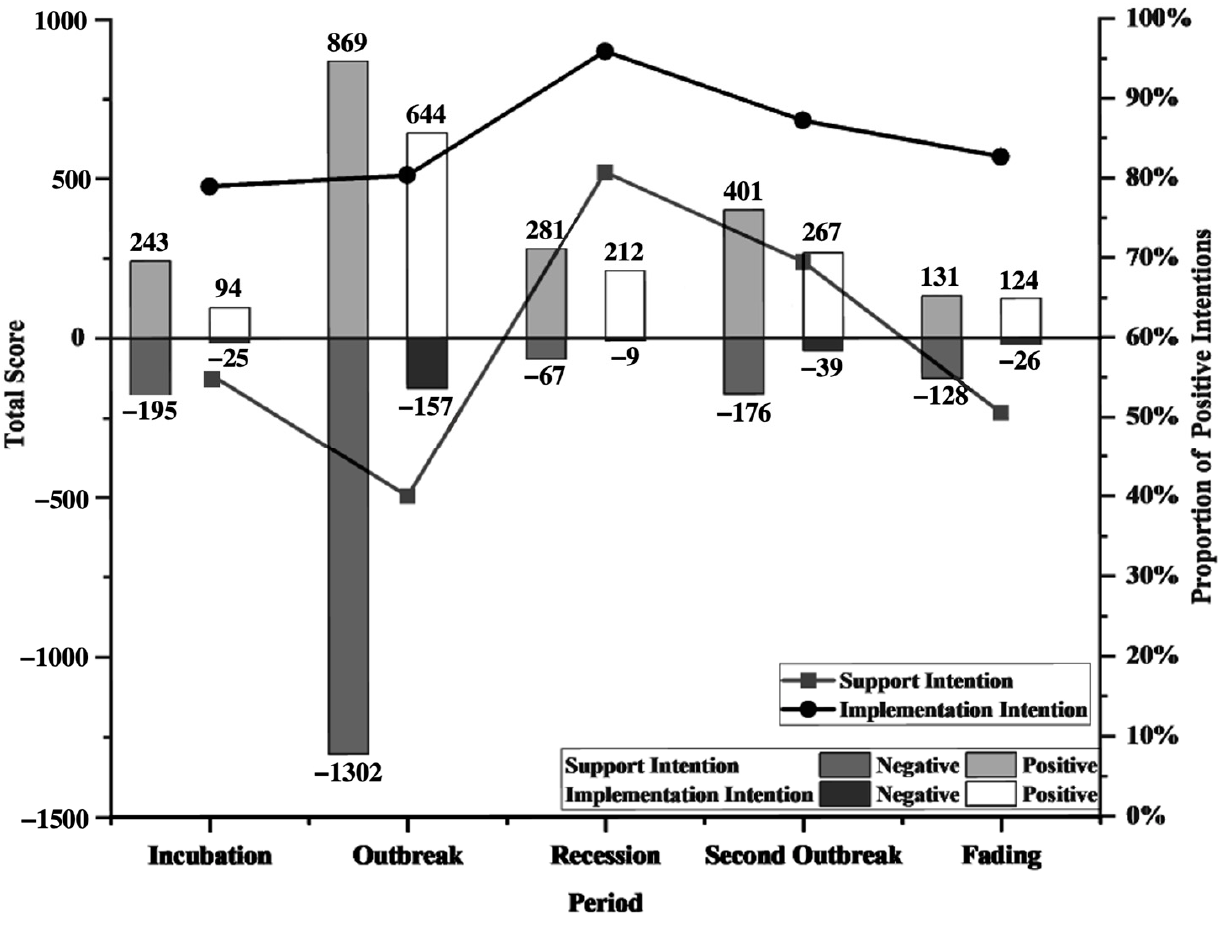
Figure 2. Combination diagram of changes in the total score and the proportion of positive emotions of public support, implementation intention in different periods.